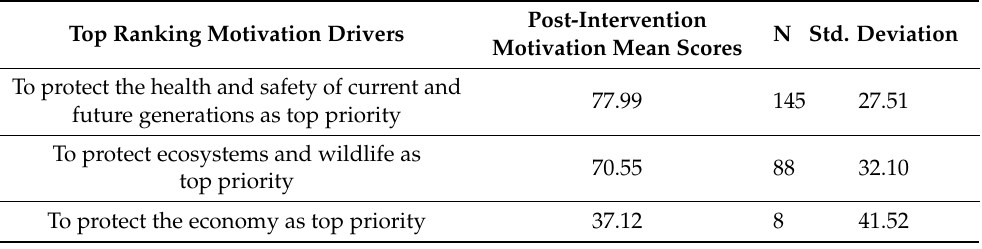
Table 3. Comparison of Post-intervention Motivation Scores with Post-intervention Top Ranking Motivation